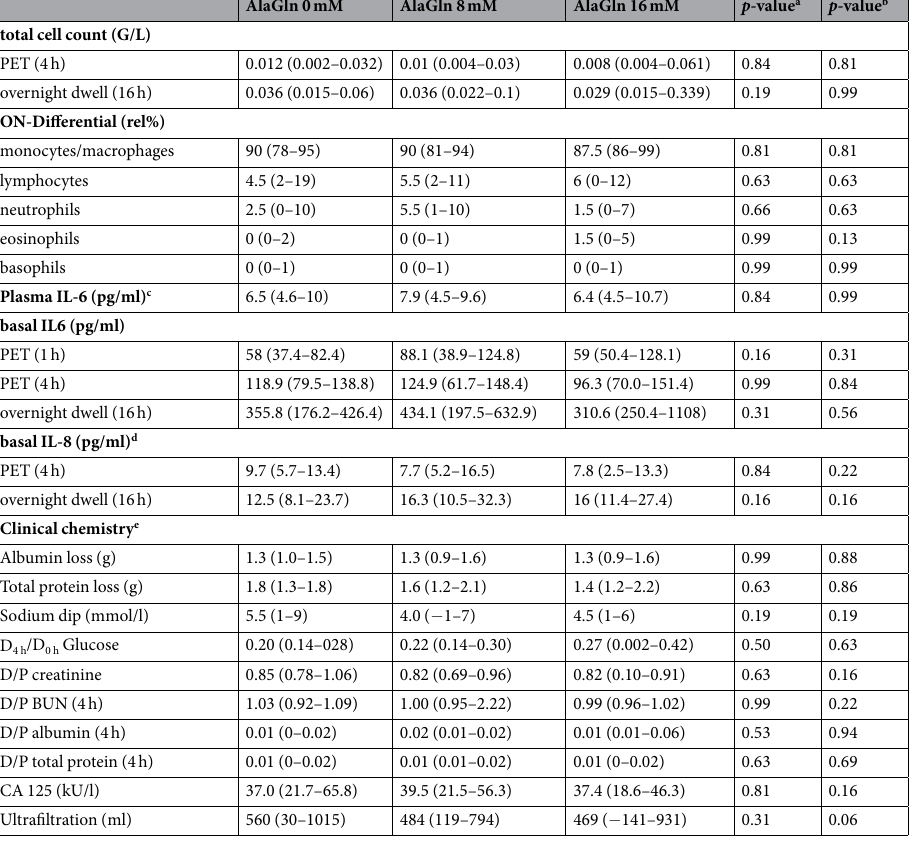
Table 2. PD effluent parameters. Data are represented as median (range) of all 6 patients enrolled in the feasibility trial. Wilcoxon matched-pairs signed rank test was used to calculate p -values. a Comparison control without AlaGln versus 8 mM AlaGln in PDF. b Comparison control without AlaGln versus 16 mM AlaGln in PDF. c IL-6 was measured in EDTA plasma samples at the 2 h time point of the PET. d Basal IL-8 was